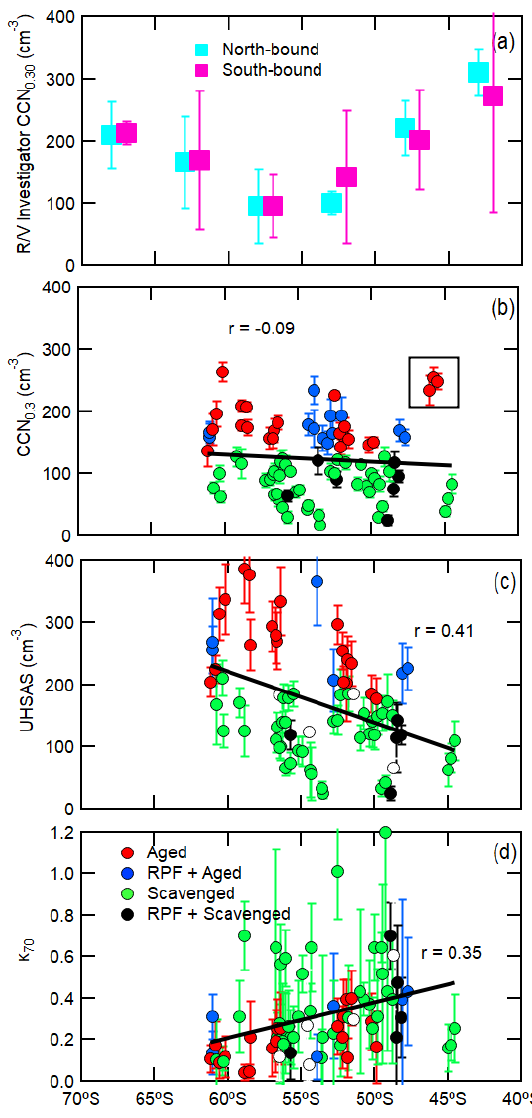
Figure 6. (a) The 5 ◦ latitude bin averaged CCN 0 . 3 from the R/V Investigator . Correlation of latitude to (b) HIAPER GV CCN 0 . 3 , (c) total particle concentration with D p > 0 . 07µm (UHSAS), and (d) κ derived at 0.07µm. White points in (c) and (d) did not have a corresponding CCN 0 . 3 or CN measurement. Pearson’s coefficient for (b) is r = − 0 . 27 when excluding the three outliers at ∼ 46 ◦ S highlighted in the black square. Error bars represent the standard